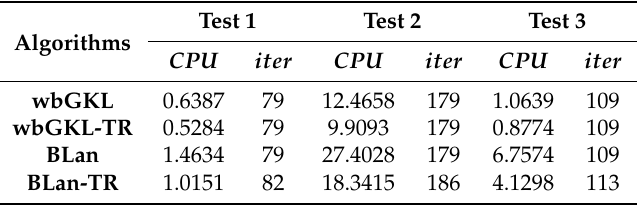
Table 7. Compute 5 largest eigenvalues for Test 1–3.